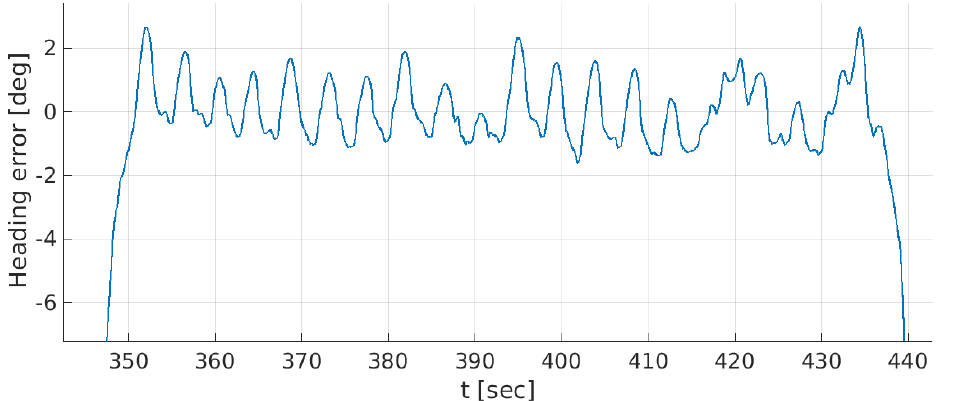
Figure 22. Heading error, employing the ALICE configuration along a single